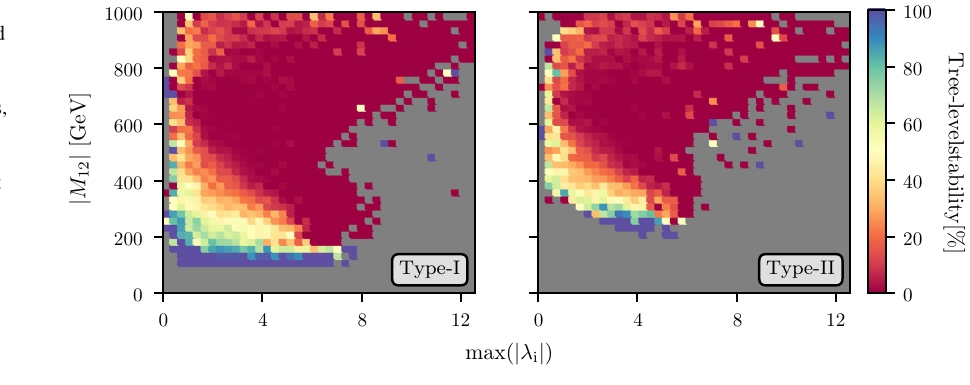
Fig. 9 Per-bin percentage of points that would have survived the one-loop vacuum stability constraints but would not have passed the tree-level conditions, as a function of | M 12 | and max ( | λ i | ) , evaluated at the electroweak scale. The left plot shows the case of type-I Yukawas and the right one a Yukawa texture of type-II